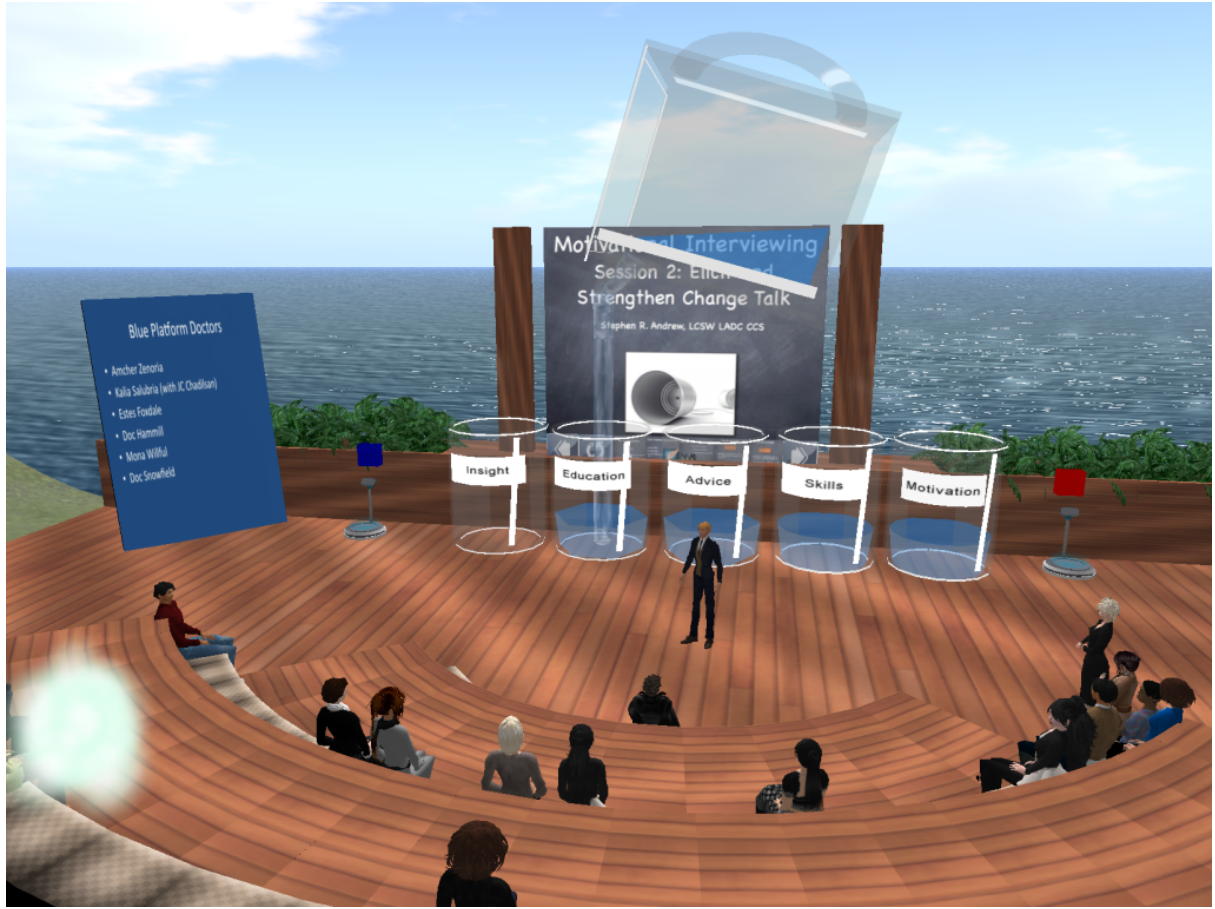
Figure 2. The virtual-world venue for motivational interviewing in Second Life